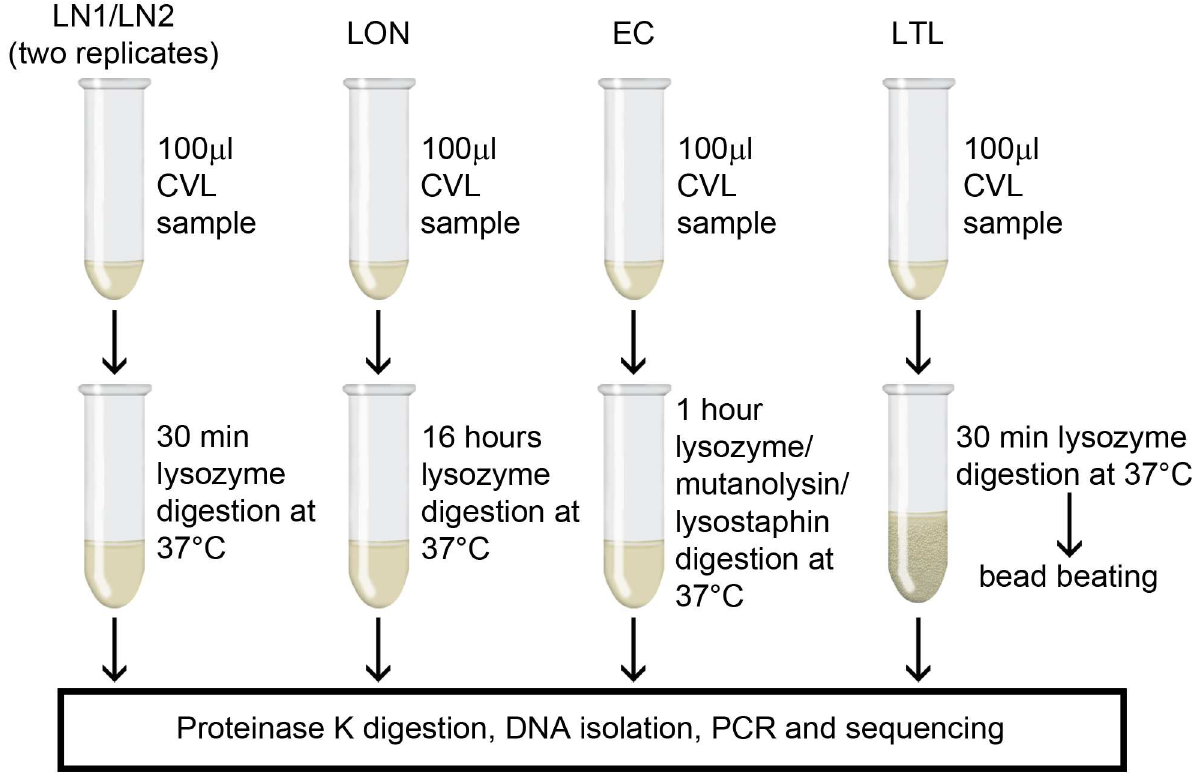
Fig 1. Overview of experimental design. Schematicshowing how samples were processedfor 16S rRNA ampliconsequencing.